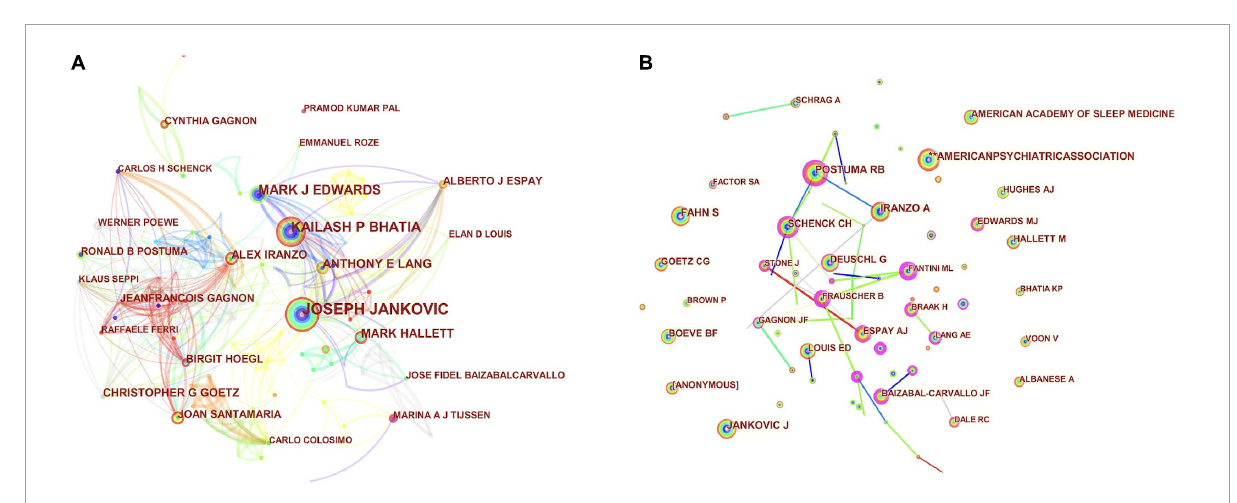
FIGURE6 Collaborative network map of authors (A) and co-cited authors (B) of exercise for movement disorders.